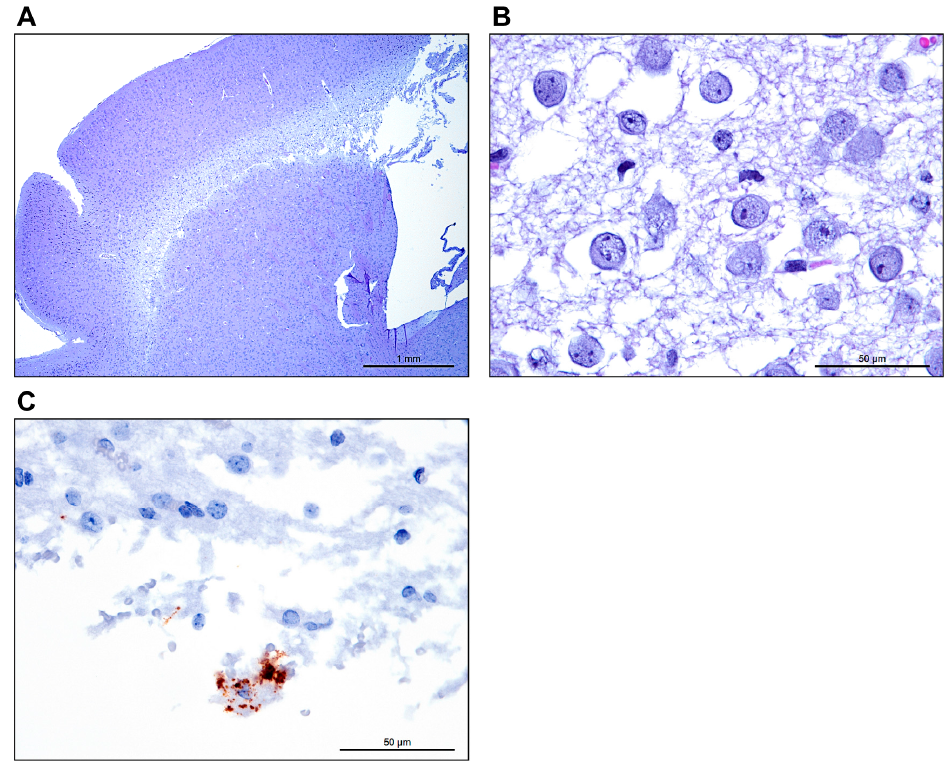
Figure 2. ( a ) Low power image taken at 25 × total magnification, 2.5 × objective shows diffuse rarefaction of the cerebral cortical white matter of the brain. ( b ) Higher magnification image